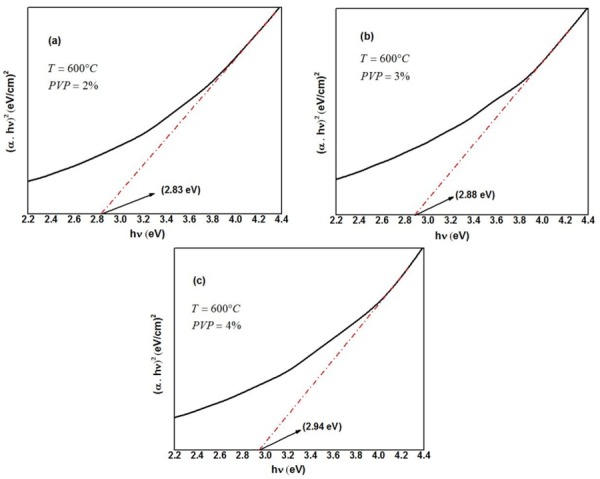
Tauc plots of Ag nanoparticles synthesized with 50 mg AgNO3 and different PVP concentrations (a) 2%, (b) 3%, and (c) 4%, calcined at 600°C.